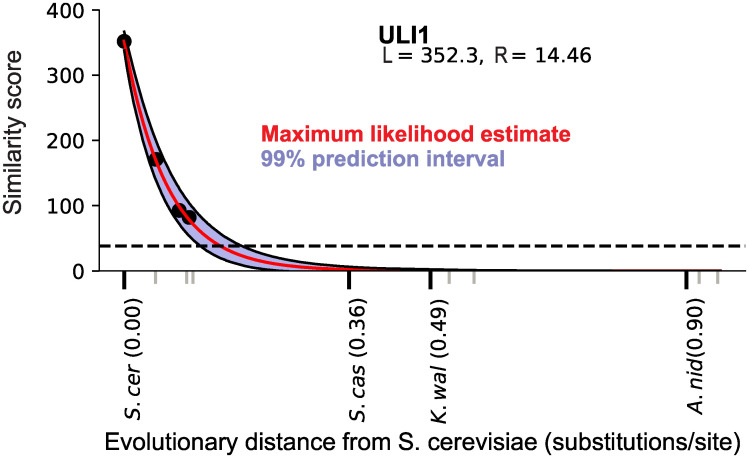
Illustration of the prediction of detectability decline for the S. cerevisiae protein Uli1, displayed as in Fig 1.At the evolutionary distance of the nearest outgroup S. castellii, the entire prediction interval lies below the detectability threshold, indicating an approximately 0% probability that an ortholog would be detected under the null model even if an S. castellii ortholog were present. Data in this figure are available at https://github.com/caraweisman/abSENSE/tree/master/Fungi_Data.